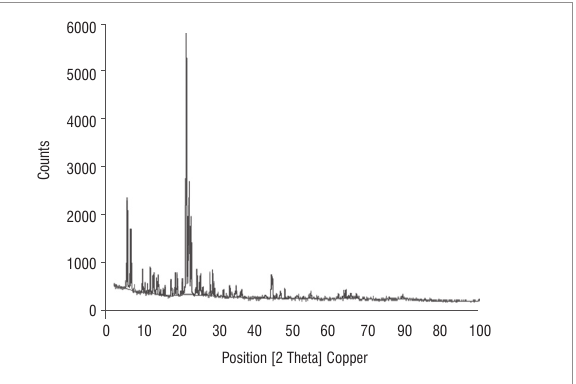
Figure 4: (a) Top and (b) cross-section of a scanning electron micro- graph of the double-layered mordenite framework inverted (MFI) membrane.